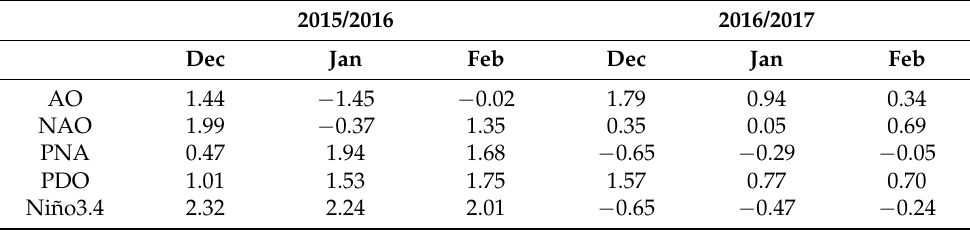
Table 2. Values of the teleconnection indices for winters 2015/16 and